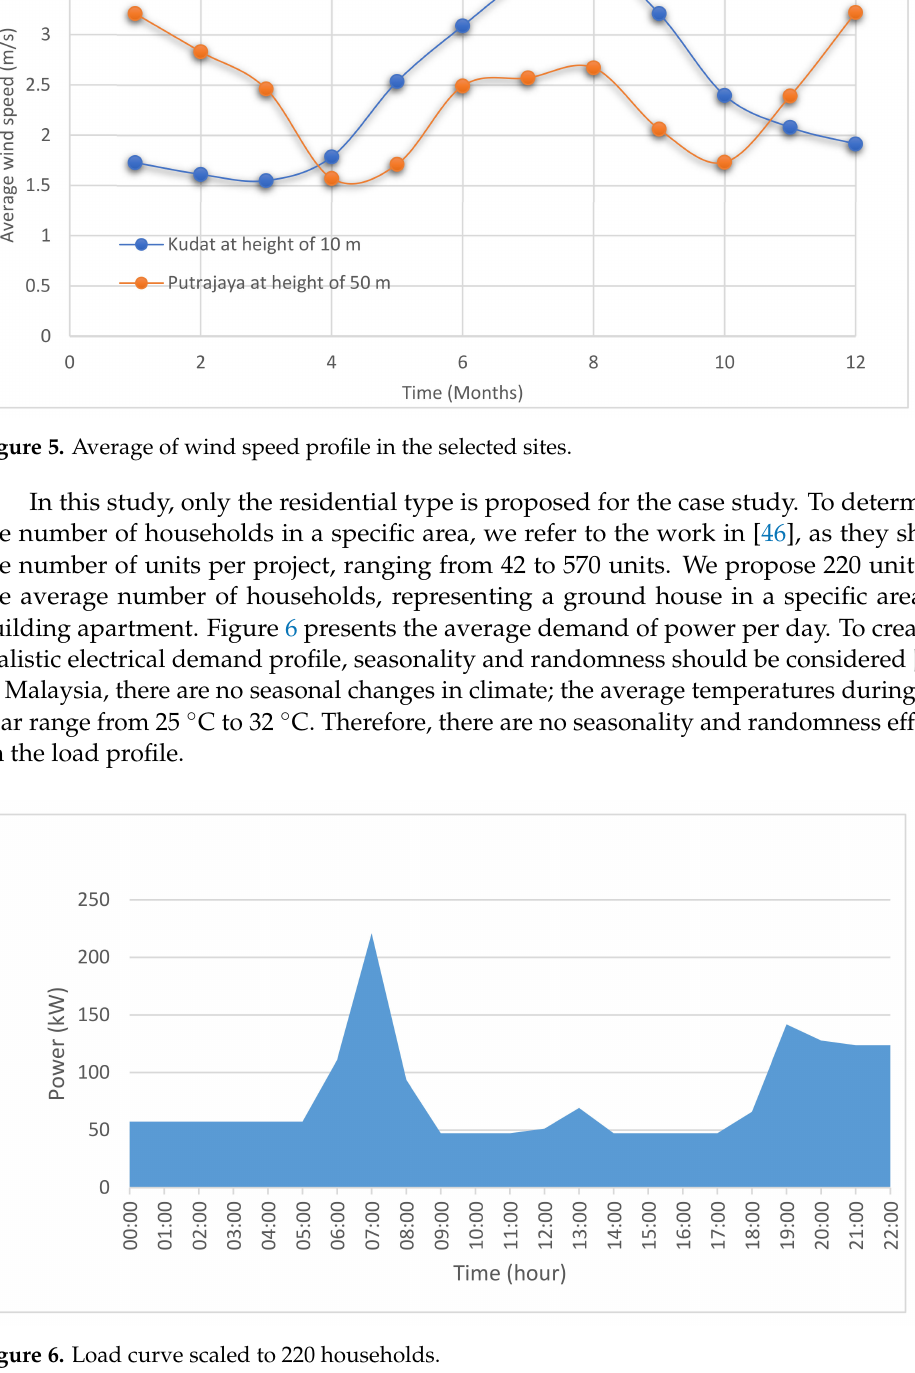
Figure 6. Load curve scaled to 220